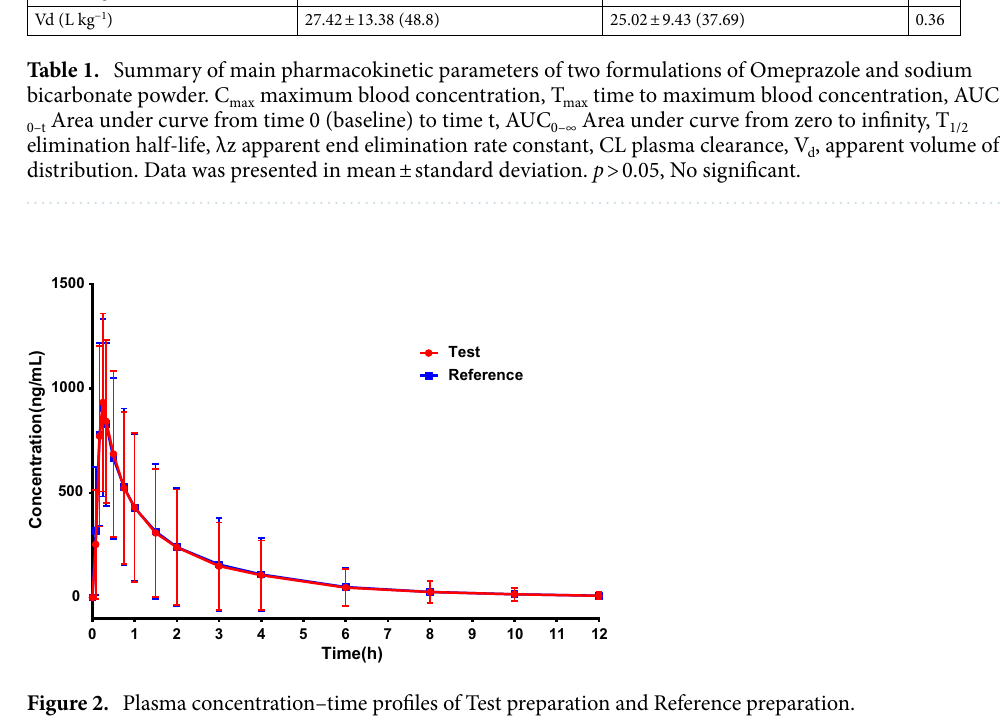
Figure 2. Plasma concentration–time profiles of Test preparation and Reference preparation.